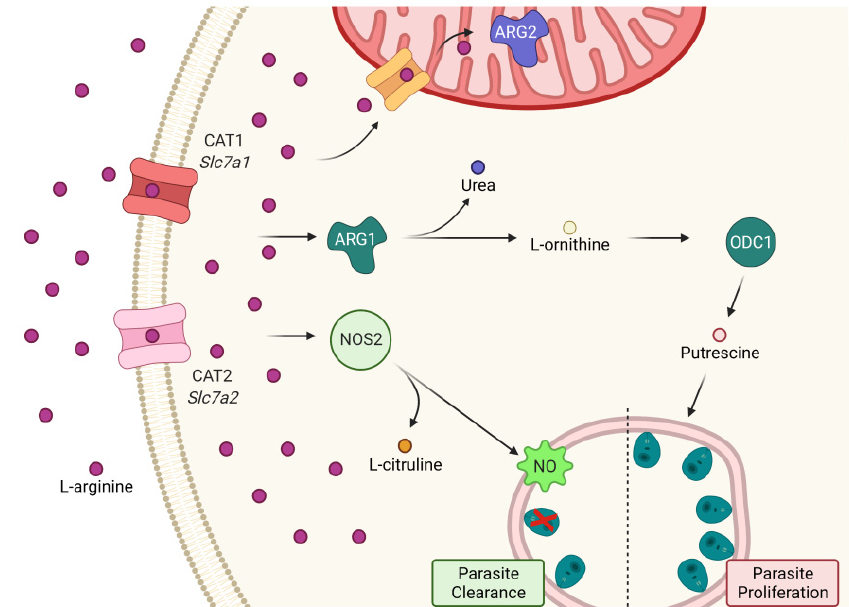
Figure 1. MicroRNAs can regulate the inflammatory branch of L-arginine uptake and consumption of infected macrophages with Leishmania amazonensis . Cells use L-arginine as one of the markers of macrophage polarization into the M1 or M2 phenotypes. During infection with L. amazonensis , macrophages obtain L-arginine via Cationic Amino Acid Transporters 1 and 2 (CAT1 and CAT2, encoded by the Solute Carrier Transporter family members Slc 7 a 1 and Slc 7 a 2). Once inside, the amino acid can be used by Nitric Oxide Synthase 2 (NOS2) to produce the NO free radical, which kills the parasite when at high levels. L-citrulline is a side product of this reaction. Another use of L-arginine is its metabolism into urea and L-ornithine via Arginase 1 (ARG1). Once converted into L-ornithine, it starts the polyamine synthesis pathway, of which Ornithine Decarboxylase 1 (ODC1) is the first branch enzyme. It is accepted that polyamines promote Leishmania survival and proliferation. L-arginine can also be transported to the mitochondrion, where it is also converted to urea and L-ornithine. However, the effects of this mitochondrial L-ornithine production are still poorly understood in the inflammatory context. This panel was created with BioRender.com online toll.